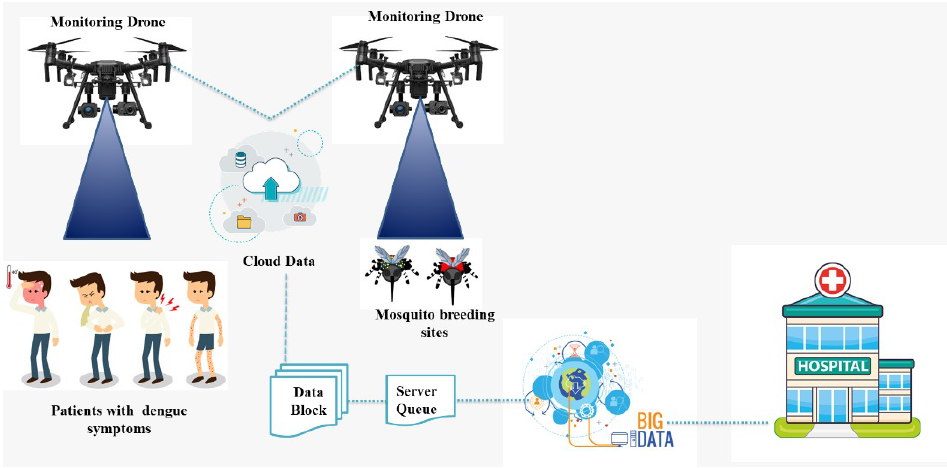
Figure 3. Framework graphical abstract.